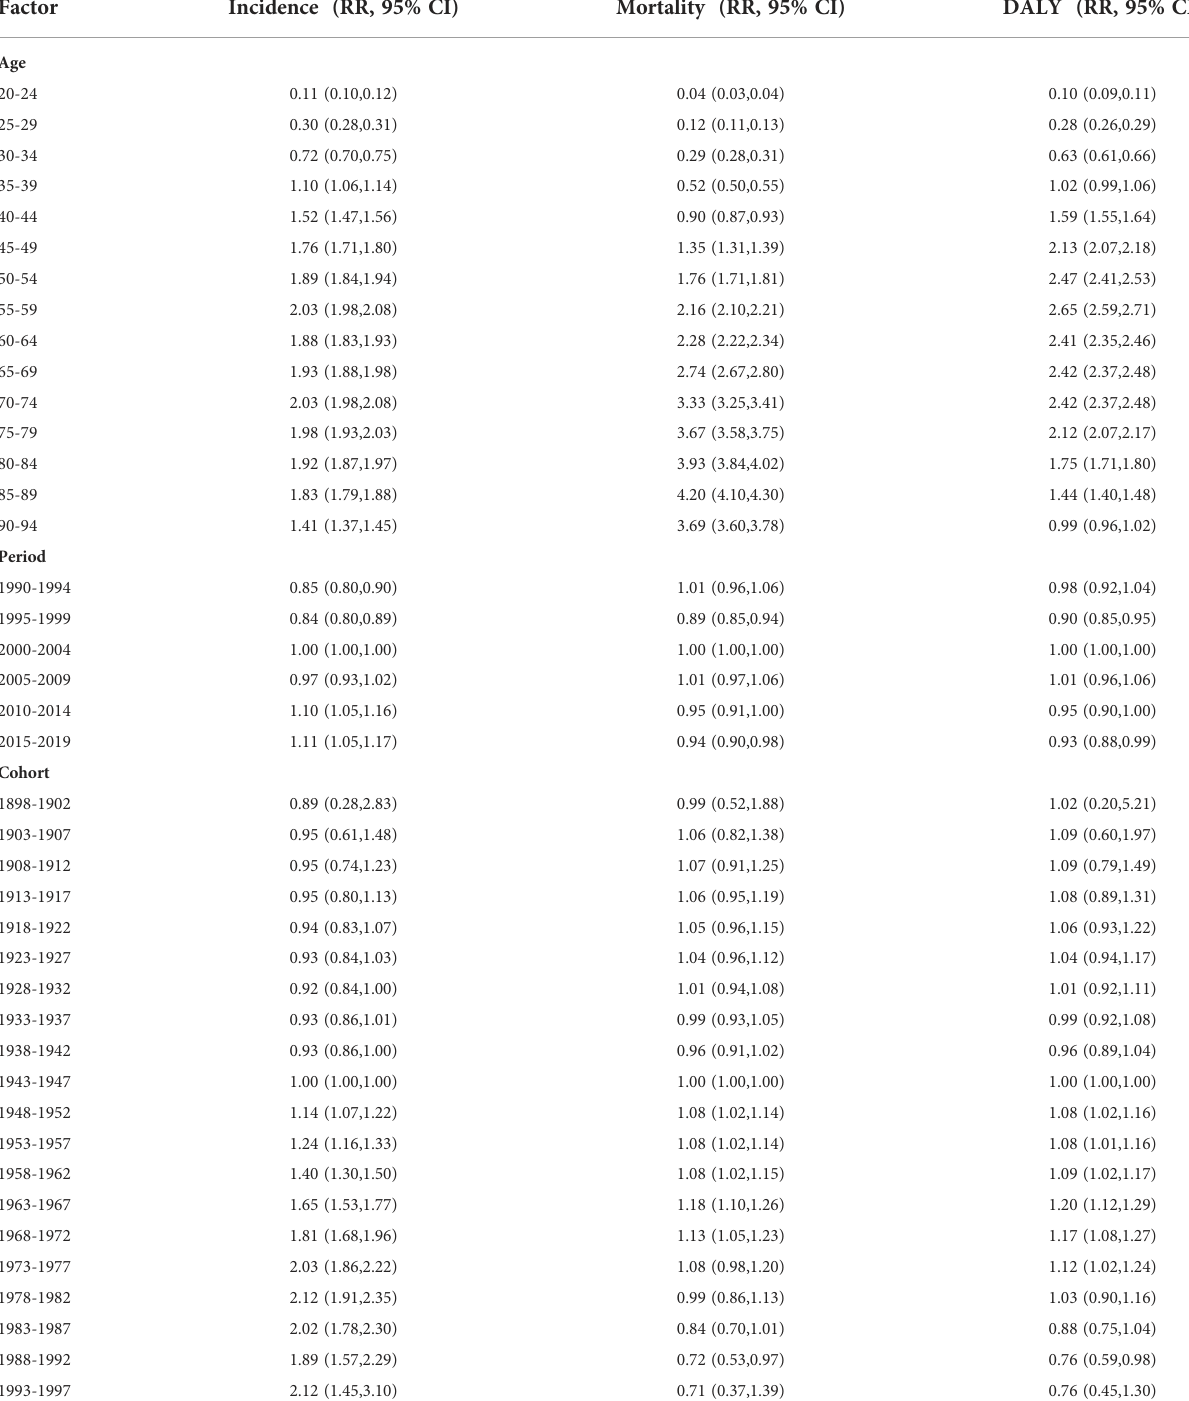
TABLE 3 Cervical cancer incidence, mortality and DALY relative risks (RR) due to age, period, and cohort effects. Factor Incidence (RR, 95% CI) Mortality (RR, 95% CI) DALY (RR, 95%